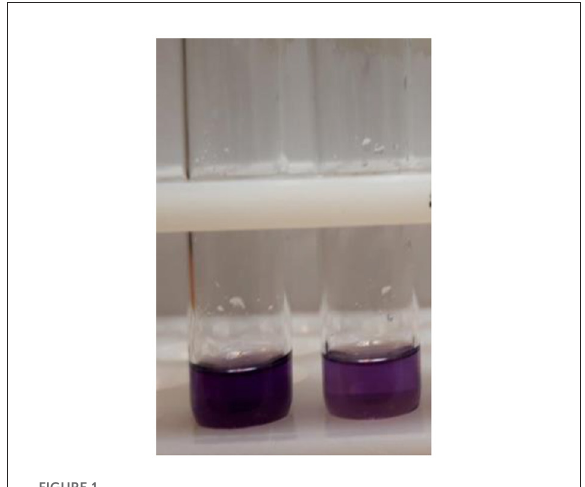
FIGURE1 Two positive results.